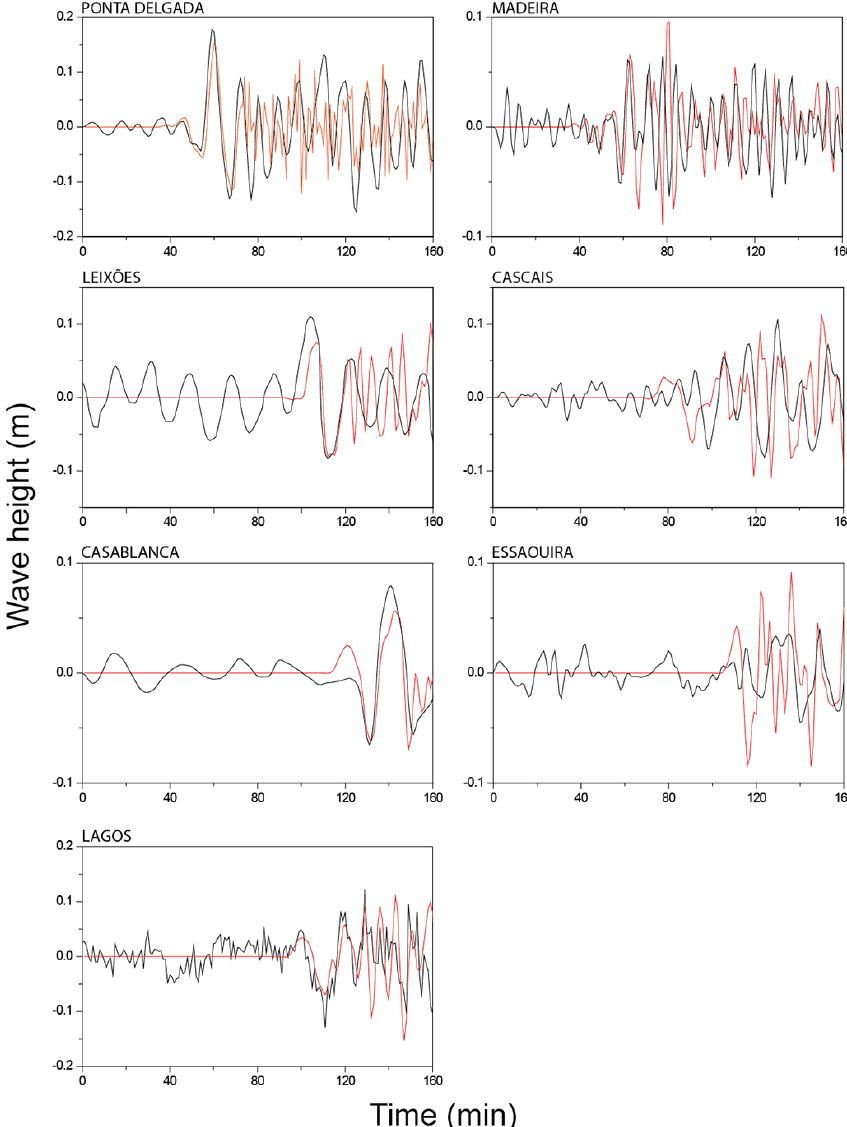
Figure 7. Comparison between observed and synthetic waveforms. The solution shown corresponds to r = 8, p = 03. Red Line depicts the synthetic waveform. Black line depicts the observed waveform. Time zero is the time of the